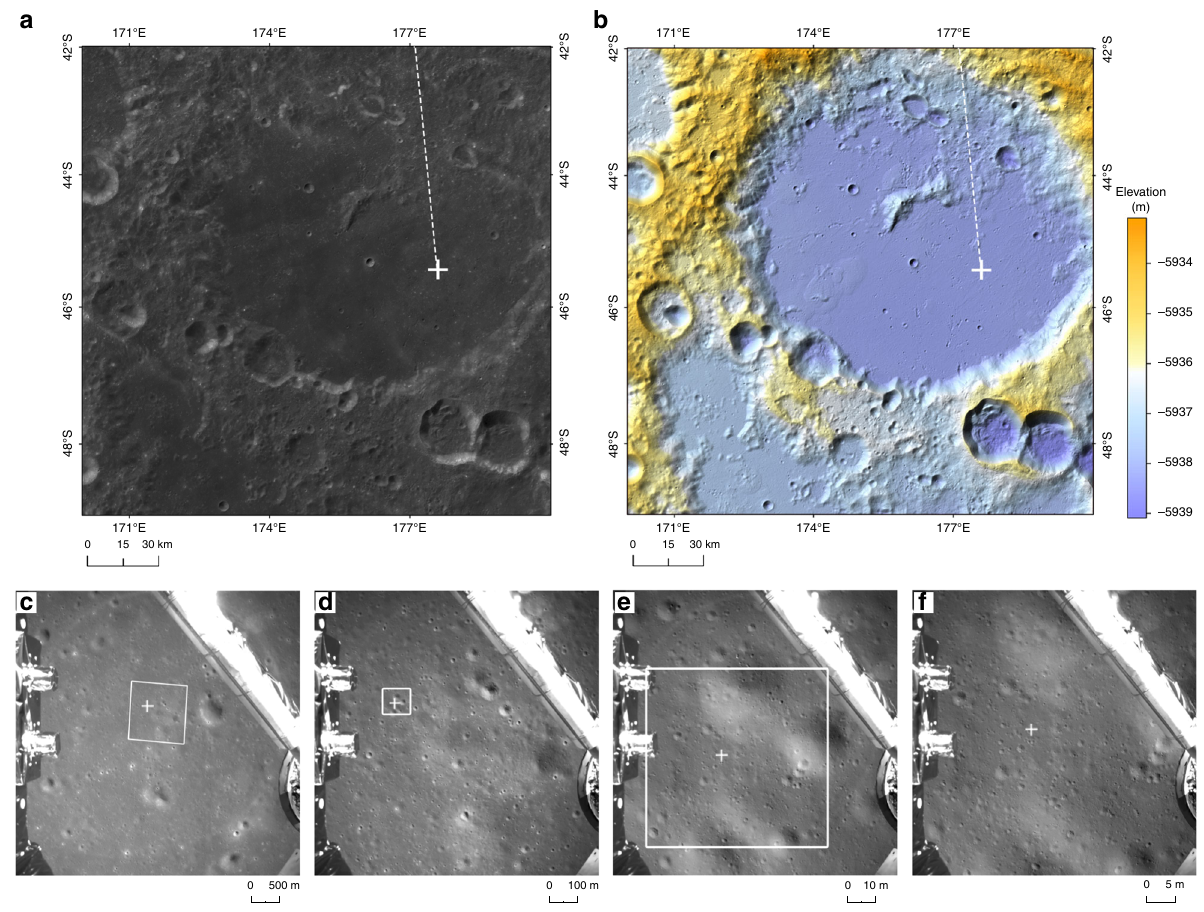
Fig. 4 The CE-4 landing site on CE2TMap2015 and CE-4 LCAM images. The + is the identi fi ed landing location. a Landing site on the Chang ’ E-2 DOM. b Landing site on a shaded-relief map made by the Chang ’ E-2 DEM. The projection is the positive-axis isometric Mercator projection, which has a standard parallel at 45°S. White dotted line represents the approach trajectory of CE-4; c – e , f are the LCAM images with spatial resolutions of 5 m/p, 1 m/p, 10 cm/p, and 5 cm/p, respectively. The white rectangles in ( c – e ) represent the borders of ( d – f ), respectively rover separated from the lander. Based on these images, topographic data of the landing site with cm-level accuracy can be reconstructed by close-range Table 3 The performance parameters of the photogrammetry. Debris scattered near the landing site can be accurately identi fi ed. Because the relationship between the location of the NCAM and the CE-4 lander is known, the precise position of the landing site can be located by combining the images of the LCAM and NCAM 25 . The main performance parameters of the NCAM are shown in Table 3. The georeferenced data used in this study are CE2TMap2015, which include the DOM and DEM with resolutions of 7m/p and 20 m/p, respectively. These data are produced using CE-2 stereo images with a resolution of 7m. The average horizontal and elevation relative position errors are 5m and 2m, respectively. Compared to the absolute positions of 5 laser re fl ectors located on the Moon, the horizontal positional deviation of CE2TMap2015 is 21 ~ 97m, and the elevation deviation is 2~ 19 m 20,21 . LRO terrain data is used for CE-4 landing site position comparison. Orbit overlap analyses show that, LRO spacecraft ephemeris can be improved to less than 10m horizontally and 1m vertically by combining radiometric tracking data and LOLA data with the GRAIL gravity model 25 – 27 . As a result, the LRO terrain data uncertainty is about 20 meters 28 and the positional deviation from the 5 laser re fl ectors is <5.2 m 29 . A pair of LRO NAC observations of the CE-4 landing site